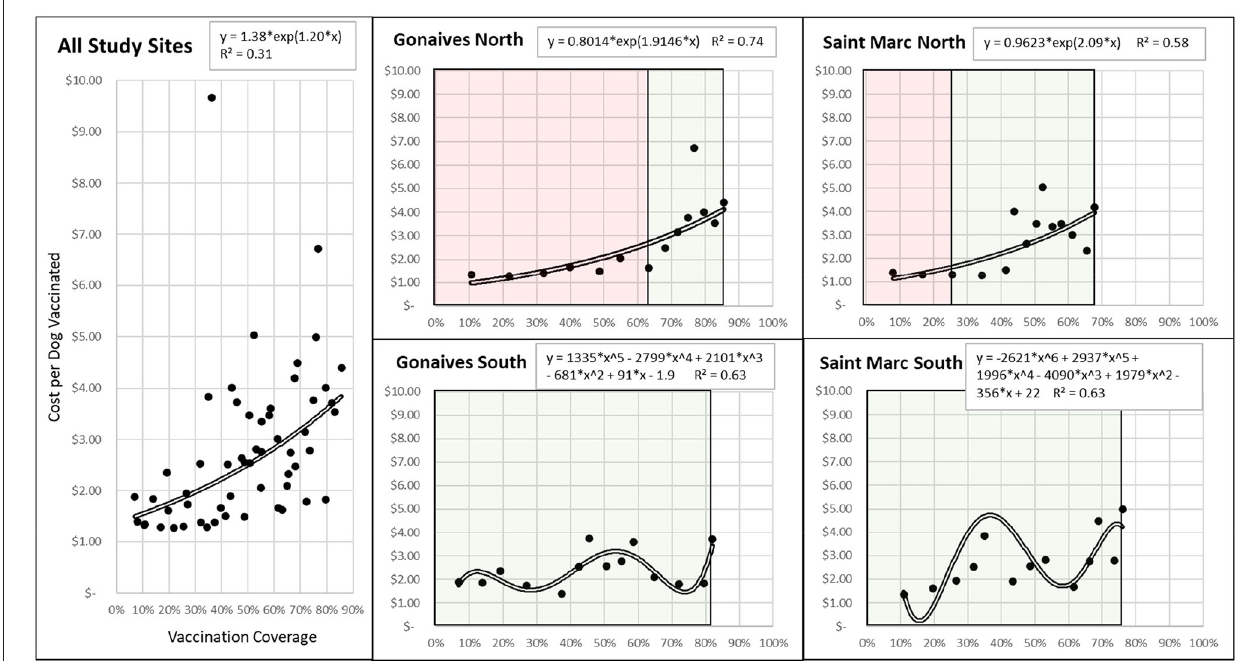
FIGURE 4 | Associations between vaccination coverage and cost per dog vaccinated during a 14-day dog mass vaccination campaign, by site and method. Black dots reflect a daily average cost per dog vaccinated at the respective vaccination coverage. Double black lines represent trendlines reflective of the functional association that explained the greatest degree of variance in the vaccination data ( R 2 ). Equations and R 2 -values are provided for comparison. Red background color represents vaccinations conducted by Traditional methods, while Green background color represents vaccinations conducted by the Technology-aided method.